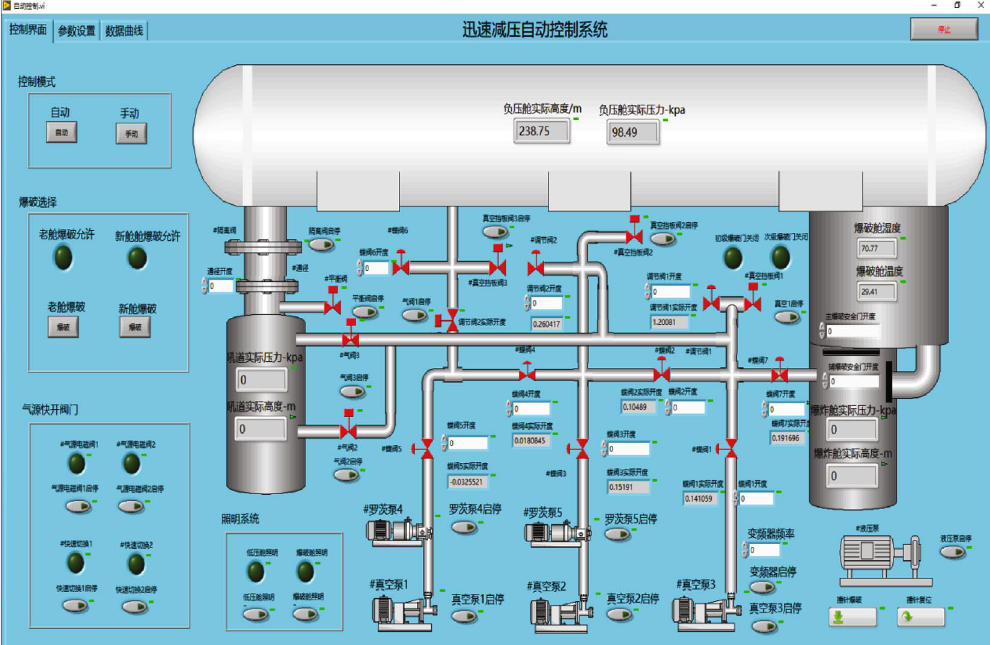
Figure 8: Rapid decompression test system.